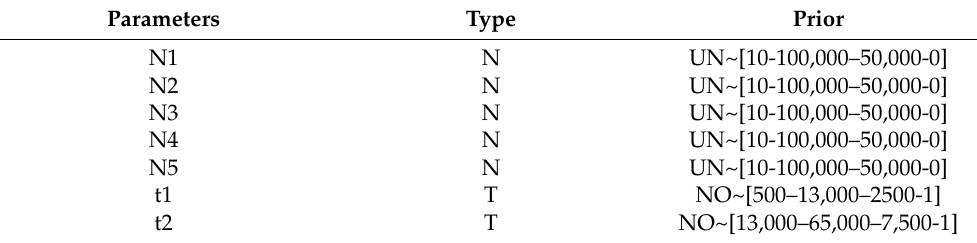
Table A2. Prior distribution for each parameter of the models used in the ABC-RF analyses. N = effective population size, T = time (in